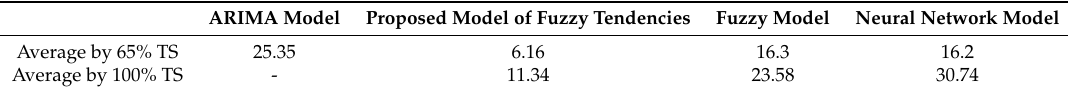
Table 11. Comparison of models in the short-term forecast of economic time series of the short length according to the SMAPE criterion%.